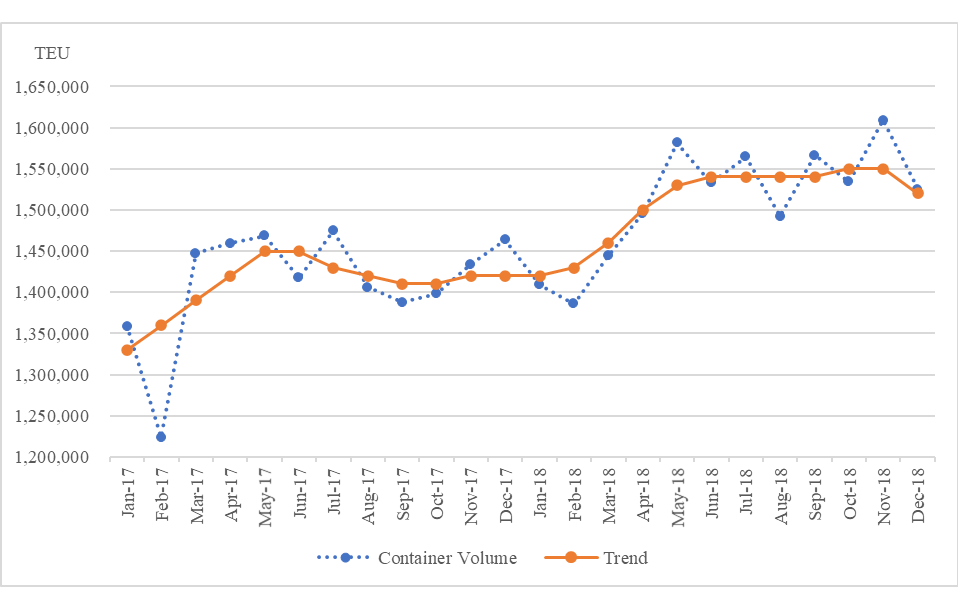
Figure 5. Comparison of container volume and trends for the years 2017–2018 (x: date, y: TEU).